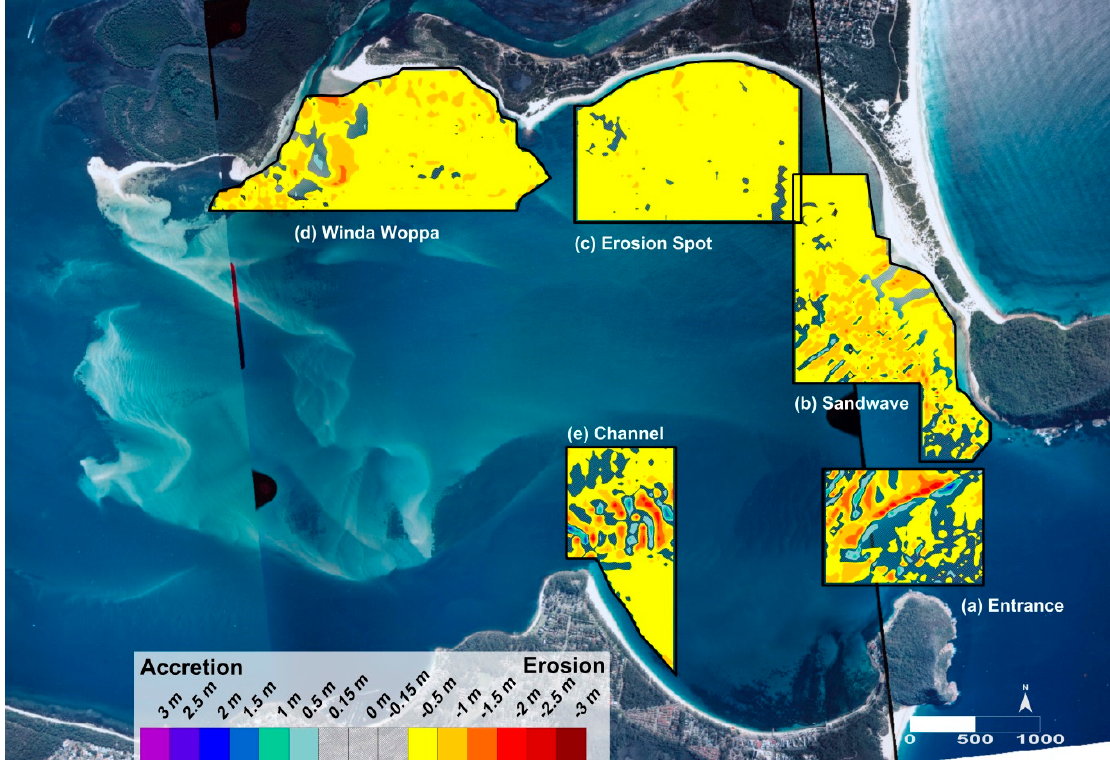
Figure 5. Comparison of 2007 and 2010 bathymetric surveys at selected sites showing dynamic characteristics of the ( a ) entrance and ( b ) sand wave, and observed at the ( c ) erosion spot, ( d ) Winda Woppa, and ( e ) channel relative to the more uniform changes.